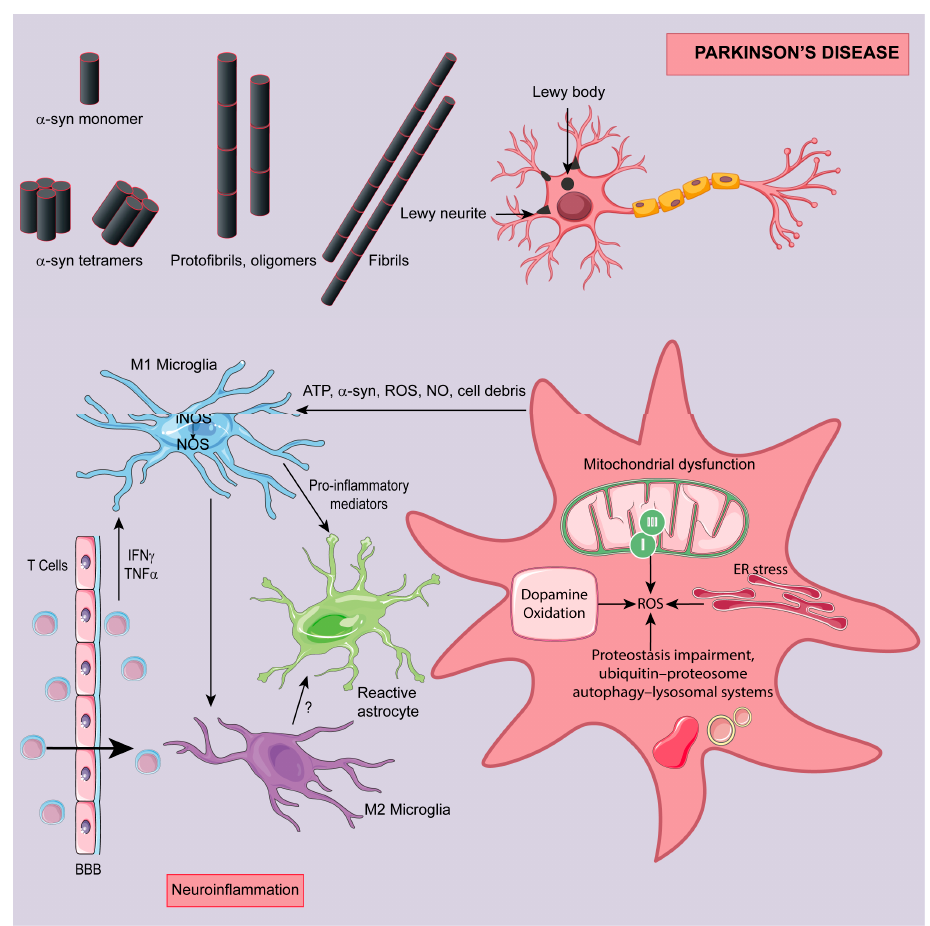
Figure 5. Diagrammatic representation of pathogenic mechanisms of Parkinson’s disease. A-syn, alpha synuclein; BBB, blood brain barrier; ER stress, endoplasmic reticulum stress; iNOS, inducible nitric oxide synthetase; NO, nitric oxide; ROS, reactive oxygen species.